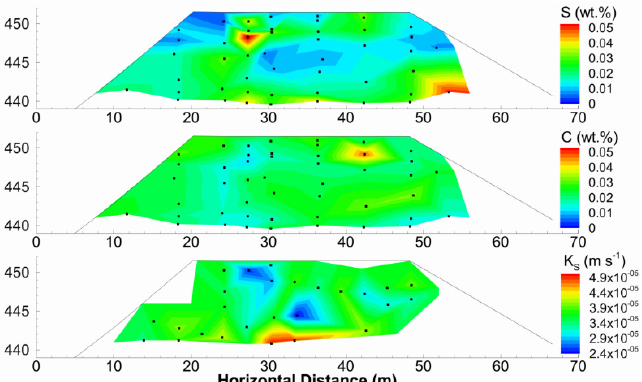
Figure 2. Location and distribution of S and C content and K S estimates from the deconstruction dataset at the east–west oriented 15 m profile of the Type I test pile (see Figure 1 for approximate location). Data were contoured using irregular data point triangulation in Tecplot 360 EX 2015. The K S estimates shown are estimated from the PSD of the matrix material. Vertical axis is elevation (m above sea level); horizontal axis starting point is arbitrary. Black dots represent sample locations; the outline represents the profile of the deconstructed test pile.